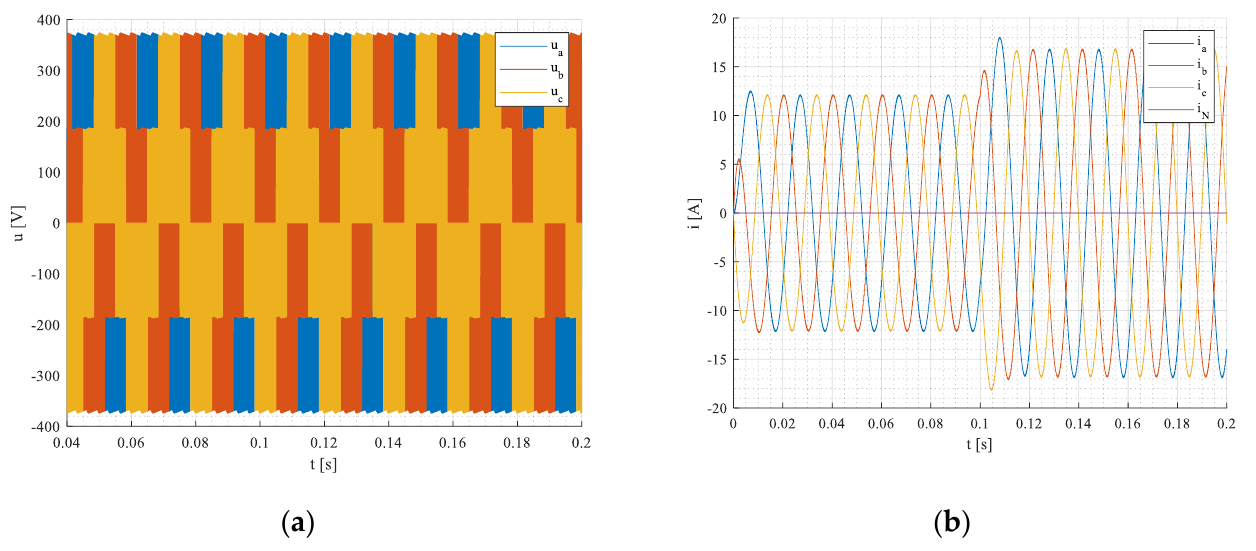
Figure 22. VSI inverter voltages ( a ) and currents ( b ) in a , b , c —coordinate system during the transient. Table 29. Load parameters for steady states before and after load change.